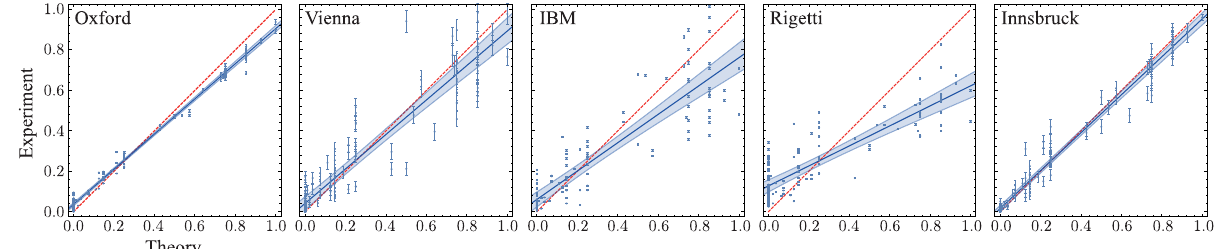
FIG. 5. Comparison between experimental outcome probabilities and theoretical expected values per single device. From left to right: Oxford, Vienna, IBM, Rigetti, and Innsbruck. As in Fig. 4, data points represent the (rescaled) outcome probabilities obtained from the respective device (Experiment), against the corresponding theory value (Theory) obtained from direct circuit simulation. For each data set, we perform linear least-squares regression (blue line) to quantify the deviation from the ideal correlation (red dashed line), yielding regression slopes with 1 σ uncertainties of 0.869(6), 0.85(3), 0.70(3), 0.50(2), and 0.94(1), respectively. Experimental error bars correspond to 1 σ statistical uncertainty, and the blue shaded bands represent 3 σ mean prediction intervals for the regression.